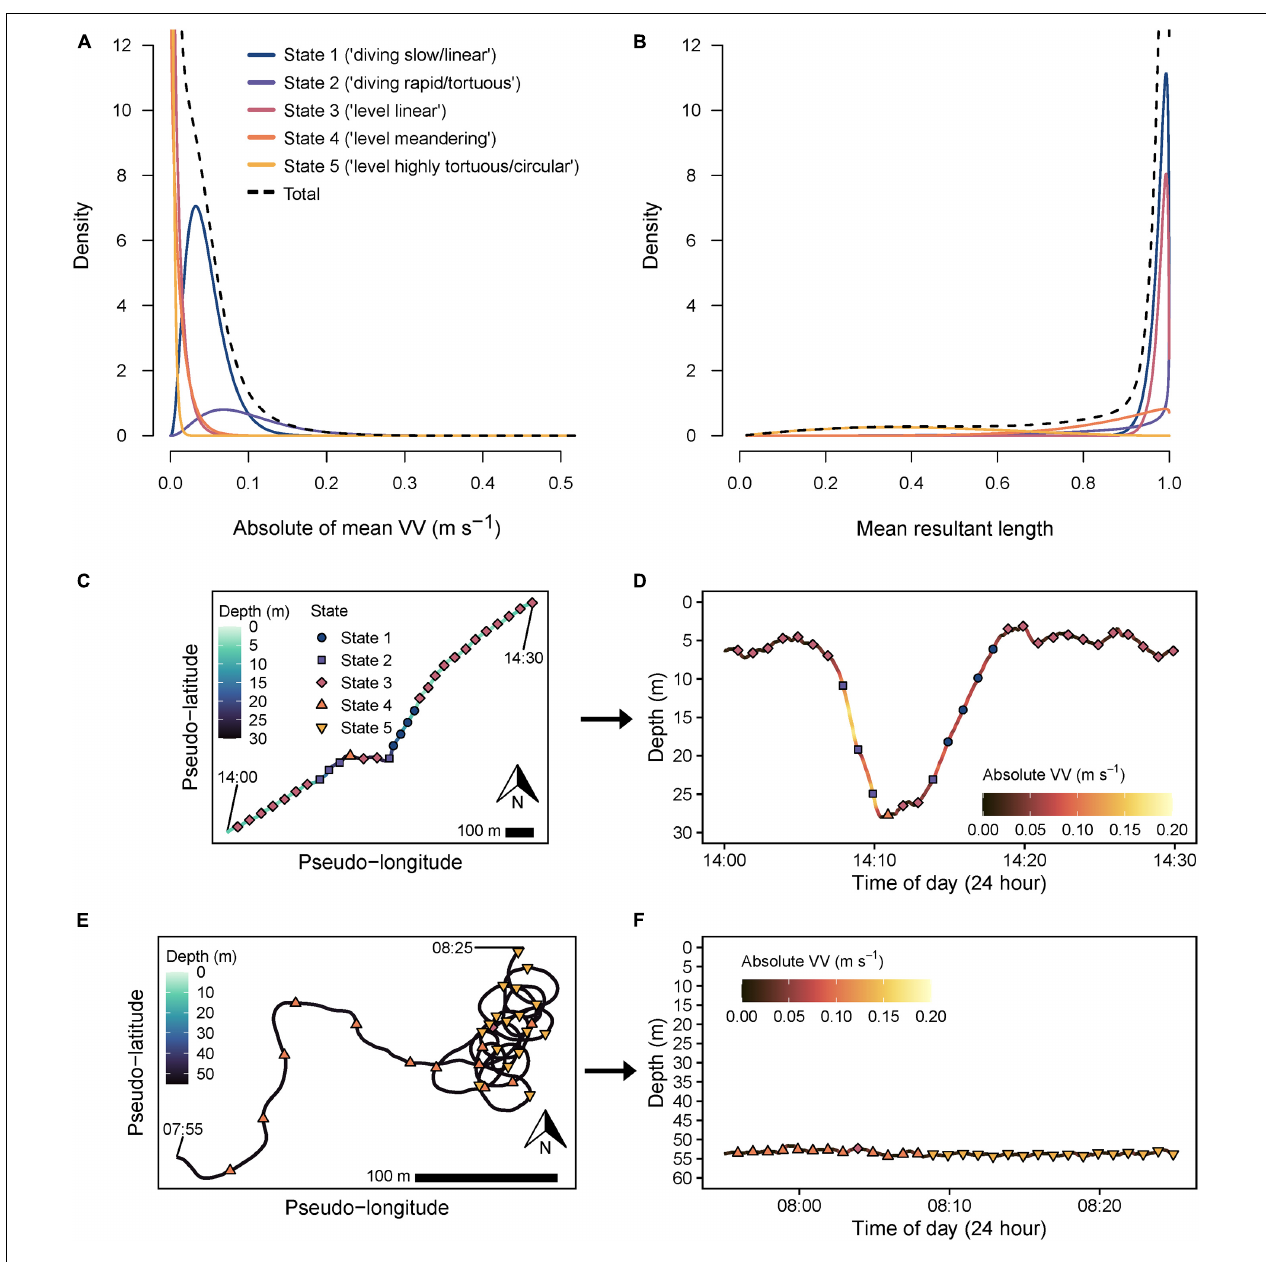
FIGURE 6 | State-dependent probability distributions for (A) absolute of mean vertical velocity (VV) and (B) mean resultant length data streams from the final selected five-state hidden Markov model. Total (black dashed line) indicates the overall pooled distribution for each data stream. Interpreted definitions corresponding to modeled states are indicated in the key in panel (A) . Representative 30 min pseudo-tracks and their corresponding depth profiles (indicated by arrows) showing track sections assigned through global decoding (Viterbi algorithm) as either (C,D) state 1 (navy circles), 2 (purple squares) or 3 (crimson diamonds), or (E,F) state 4 (orange triangle) and 5 (gold inverted triangle). Start and finish times (24 h time) are labeled to indicate track directionality. X - and Y -axes are scaled equally in each pseudo-track plot. A 100 m scale bar is provided for comparison of the approximate relative spatial scale of movements across each plot, assuming a fixed swimming speed (0.82 m s − 1 ) for all